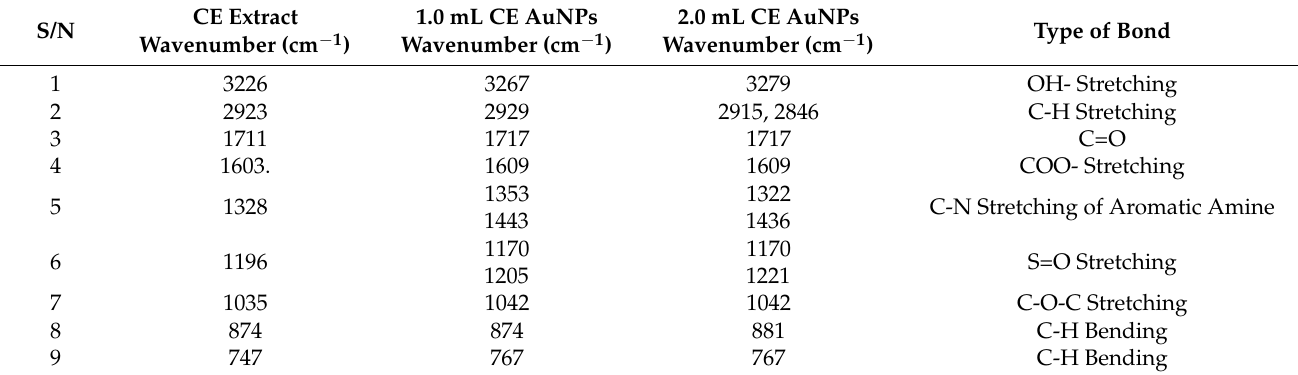
Figure 6. FTIR Spectra of ( A ) CE Extract, ( B ) AuNPs synthesised using 2 mL of CE, and ( C ) AuNPs synthesised using 1 mL of CE. Table 1. FTIR Wavenumber and Possible Bonds of CE Extract and its